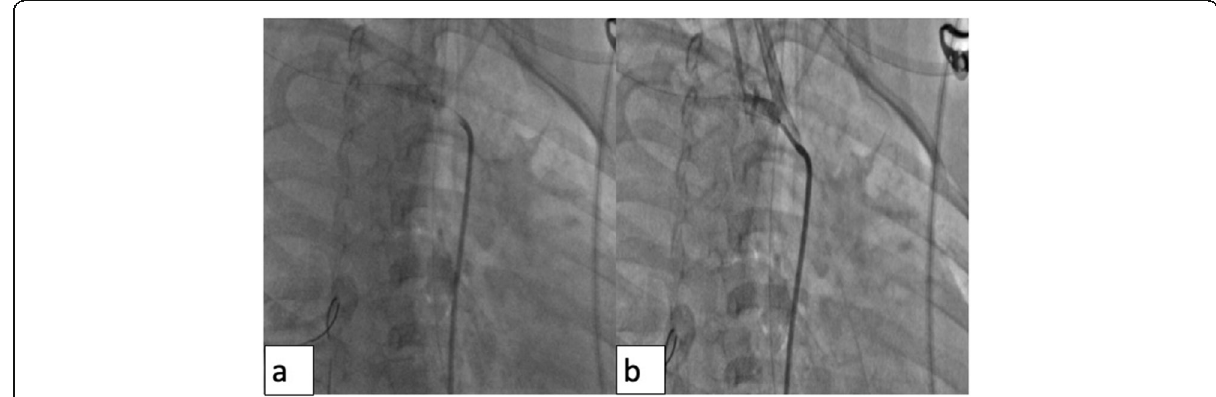
Fig. 3 a 4 × 16 mm covered stent deployed at 22 atm. b Right brachiocephalic injection showing persistent dye leak, although